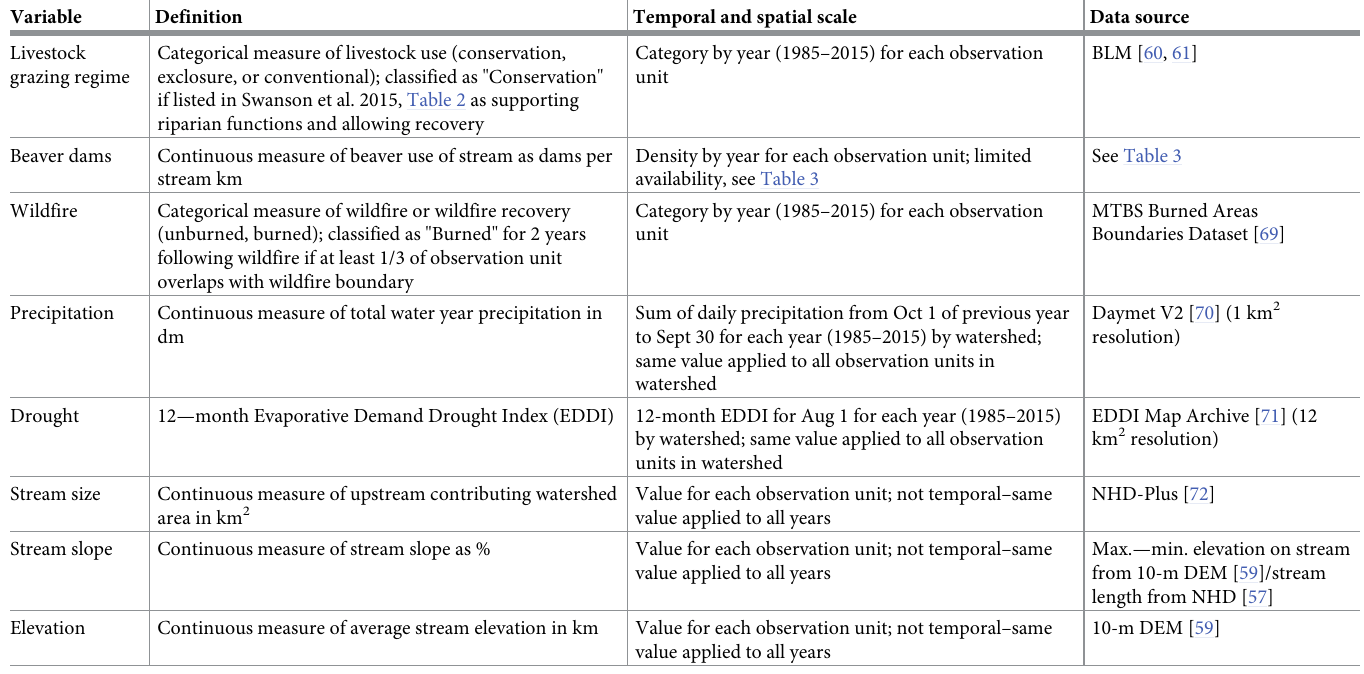
Table 1. Spatial covariates used to predict riparian vegetation